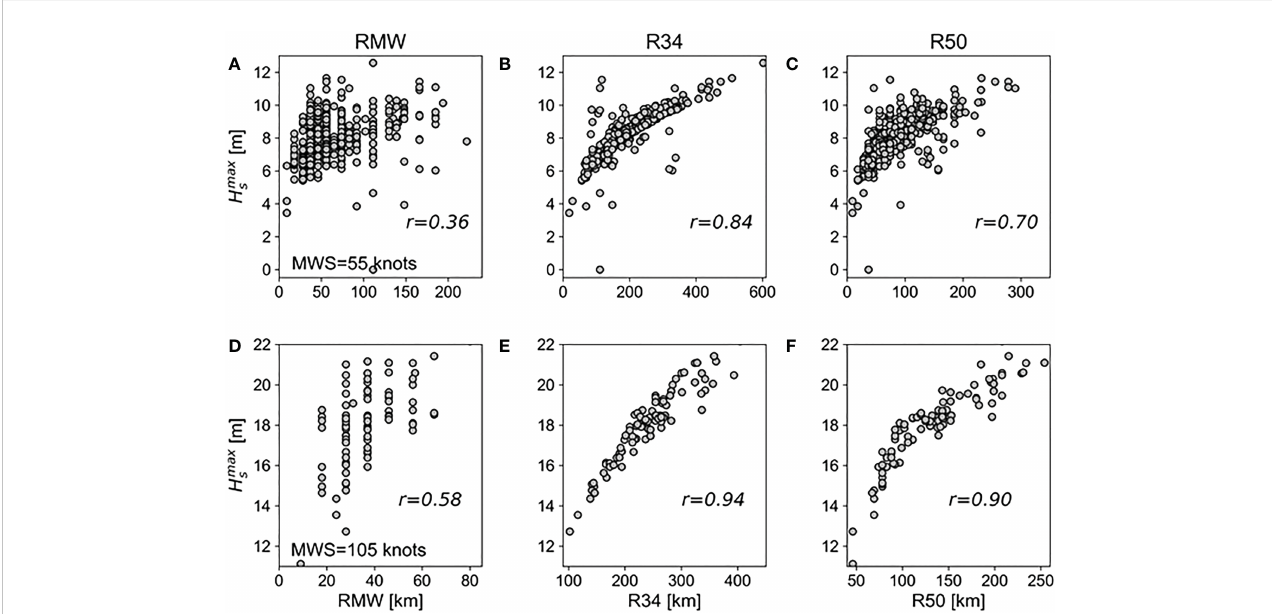
FIGURE 3 Scatter plots of simulated H max s against three TC size parameters: RMW (A, D) , R34 (B, E) , and R50 (C, F) . The H max s values were obtained from TCs with a constant translation speed ( V fm = 5.25 m s -1 ) and MWS of 55 knots (A – C) and 105 knots (D – F) . The correlation coef fi cients (r) between H max s and TC size parameters are indicated in each scatter